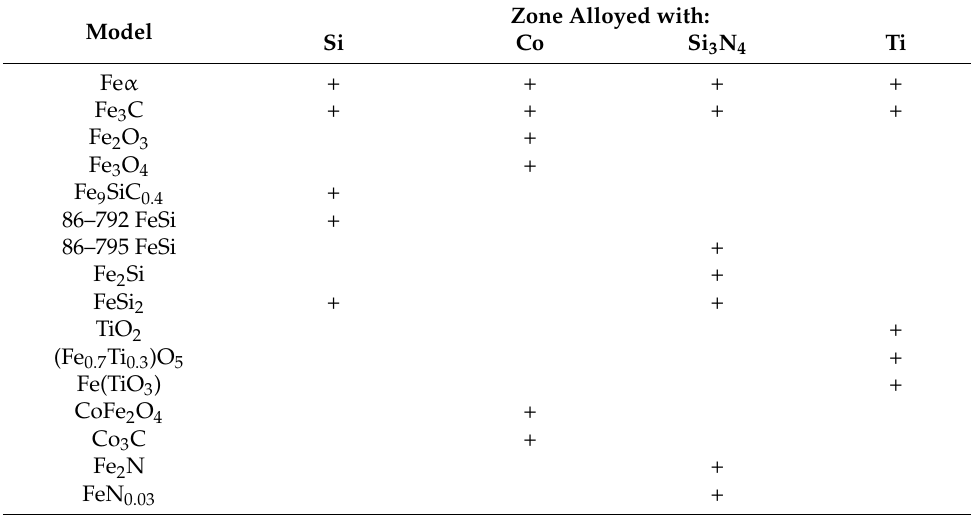
Table 2. X-ray diffraction results.